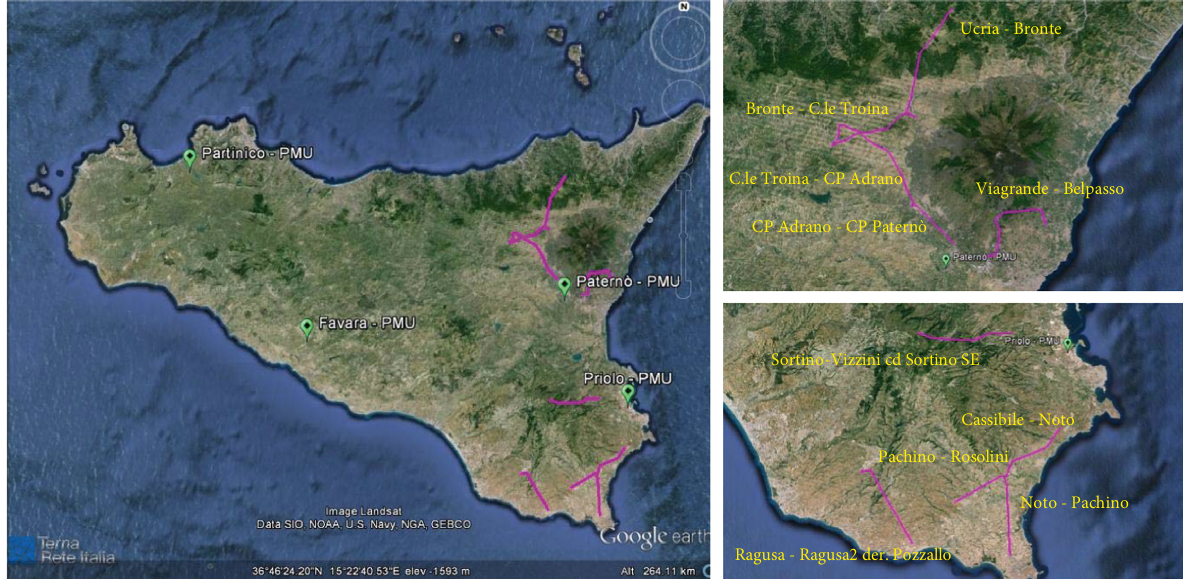
Figure 7: 150kV lines object of